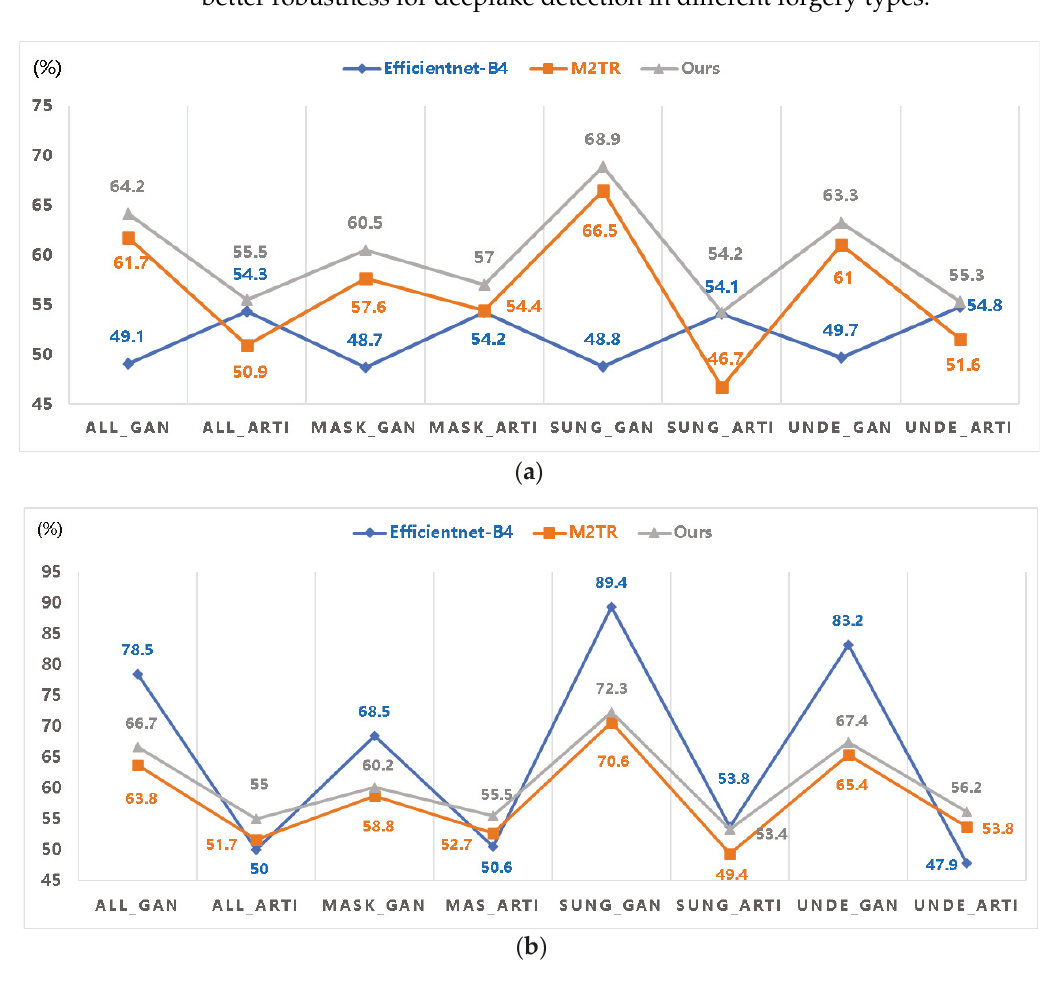
Table 6. Time-complexity comparison table with the